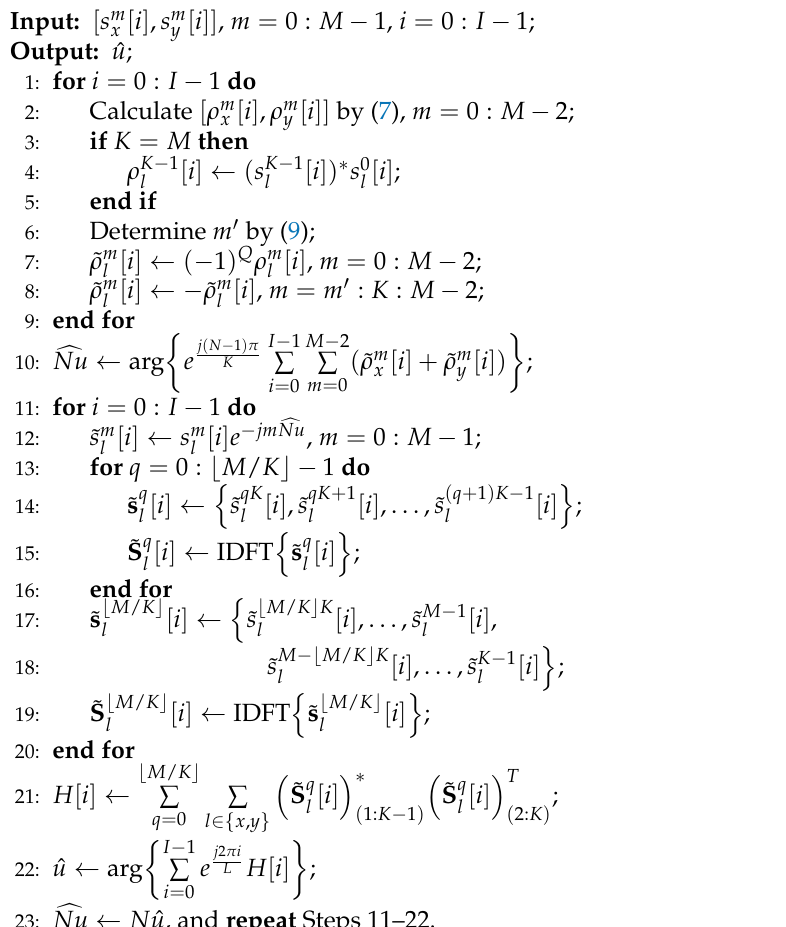
Algorithm 1 Enhanced AoA